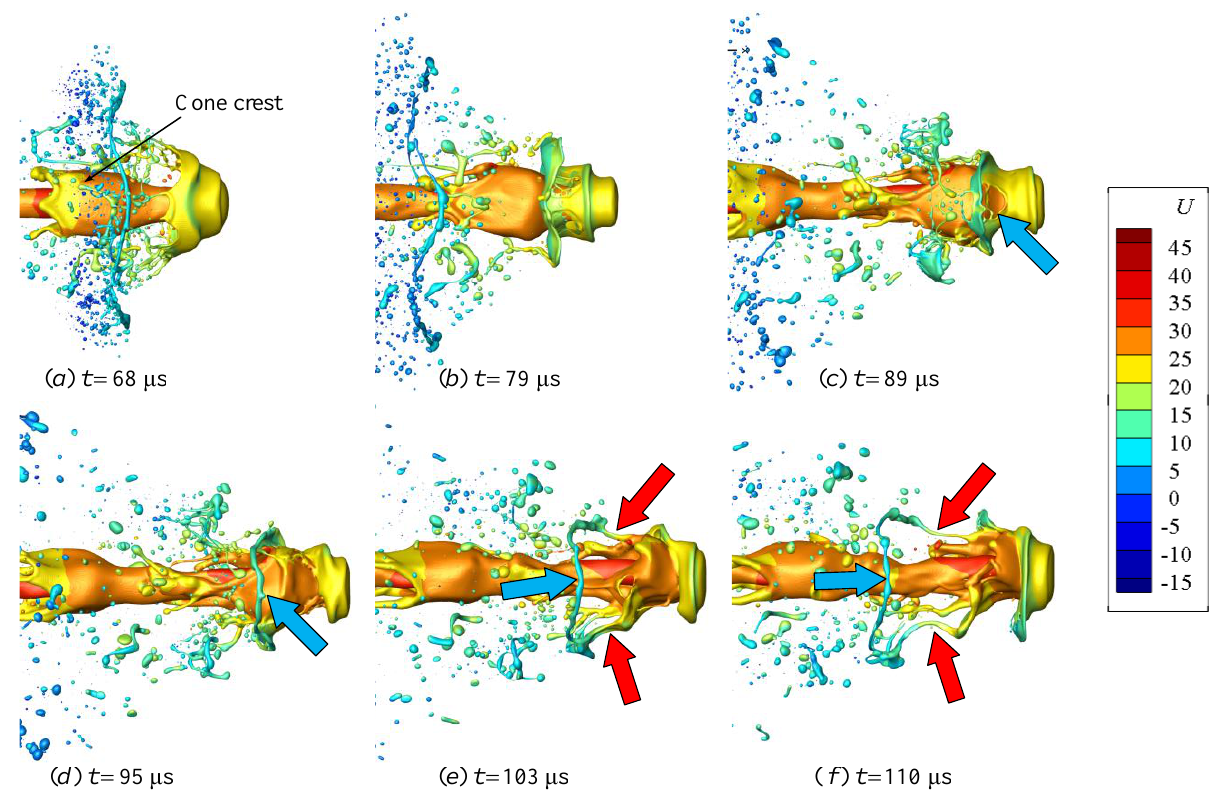
Figure 9. Ligament formation near the jet tip ( f = 66.6 kHz). The color indicates the axial velocity in m/s.